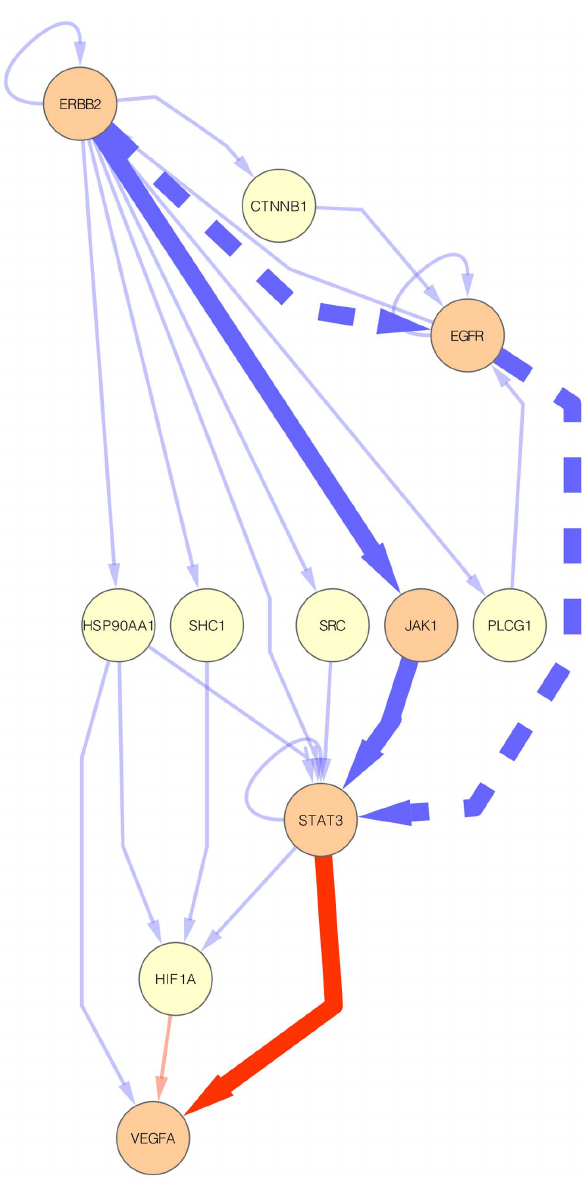
Figure 7. The ERBB2 ? VEGFA subnetwork. This subnetwork contains 24 interactions. The highlighted solid edges represent the interactions present in the corresponding OLP. The highlighted dashed edges represent the interactions of the potential oncogenic pathway (ERBB2 ? EGFR ? STAT3 ? VEGFA). Blue and red edges represent, respectively, protein physical and transcriptional regulation interac- tions; orange nodes represent genes participating in the known or potential oncogenic